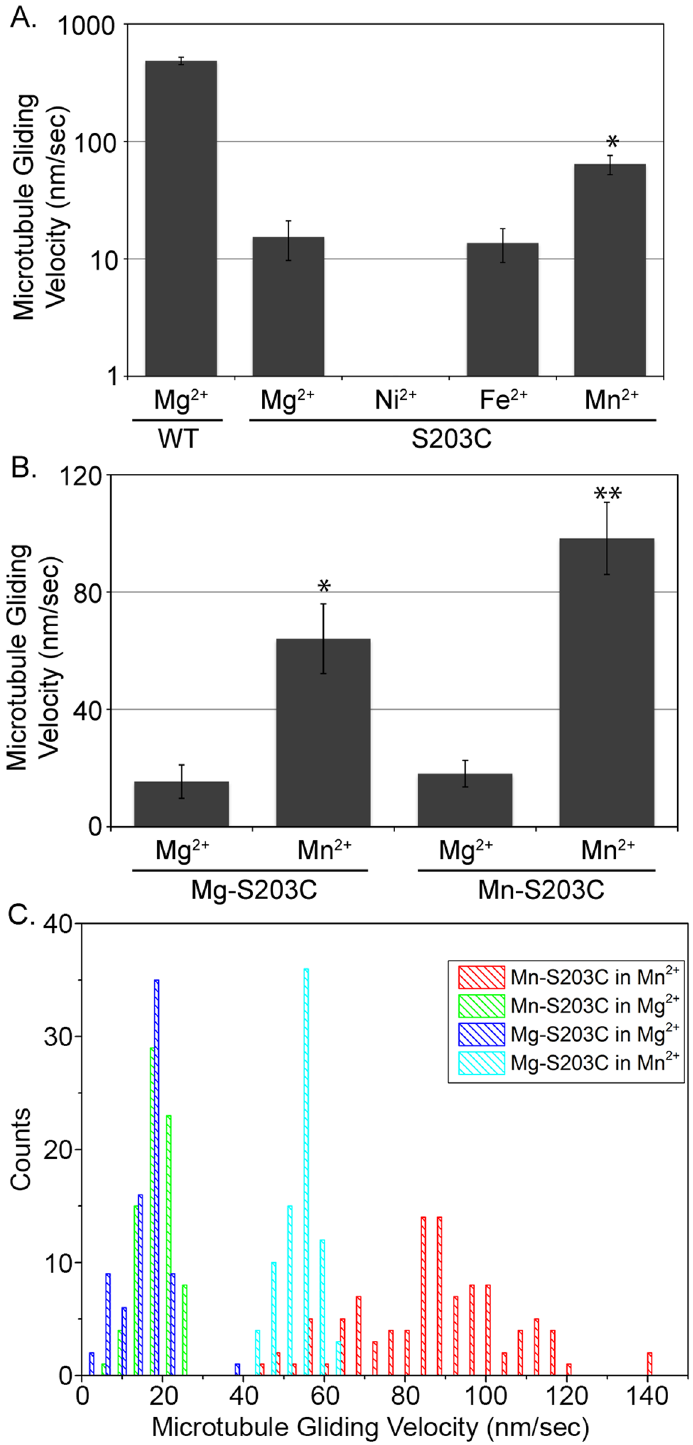
Fig 4. Effect of divalent cation on S203Cmicrotubule gliding velocity. A) Microtubuleglidingvelocity of the S203Cmutant in buffers with the divalentcations shown. The asterisk indicatesthat the velocity in Mn 2+ is significantly greater than the velocity in Mg 2+ (p < 0.01),althoughstill significantly lower than wild type in Mg 2+ (p < 0.01). Note the log scale of the Y-axis. B) Microtubule glidingvelocity of the S203C mutant that was purifiedin the presenceof Mg 2+ (Mg-S203C) and Mn 2+ (Mn-S203C). The single asterisk indicatesthat the